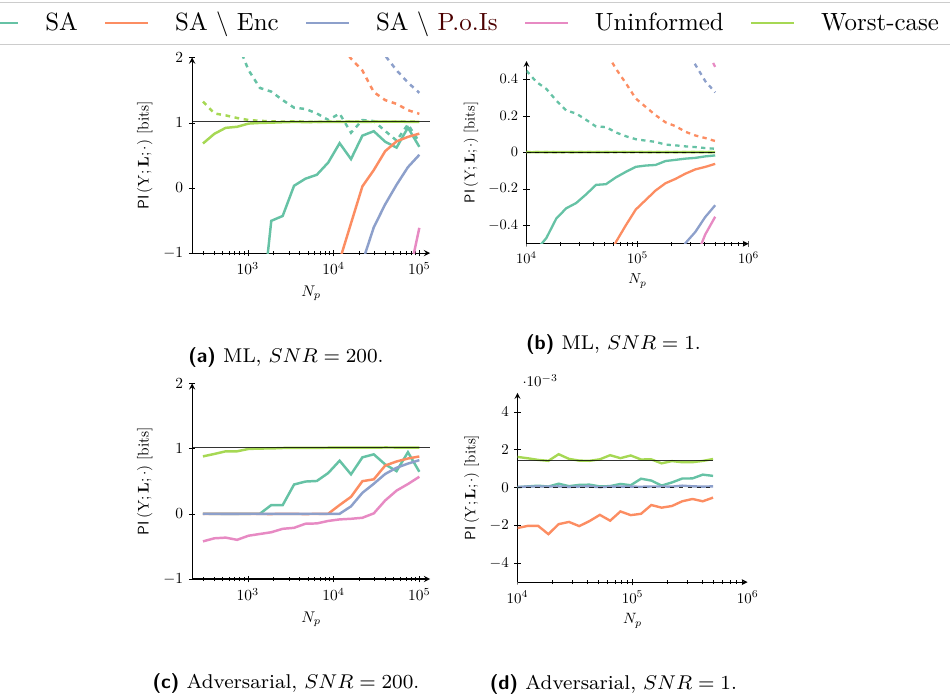
Figure 5: Learning curves for models against a second-order Boolean